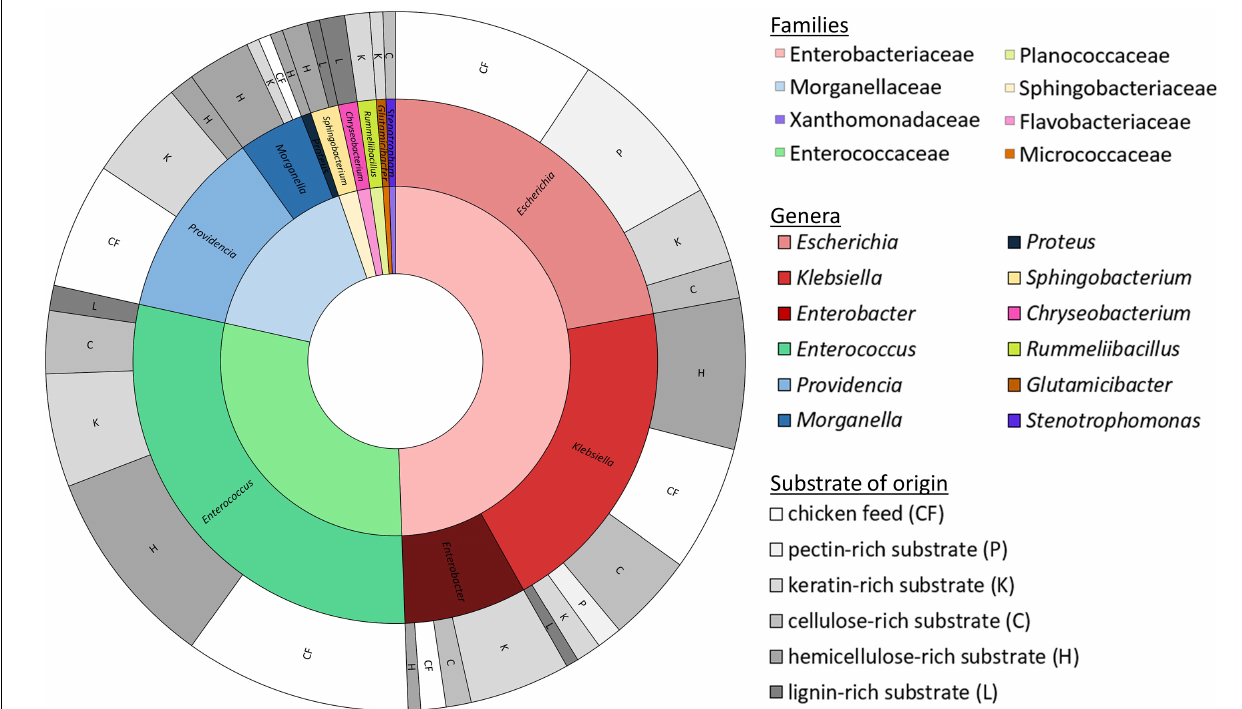
Supplementary Table 1 . For isolates identified via amplification of the 16S rRNA gene, the top-hit taxon is